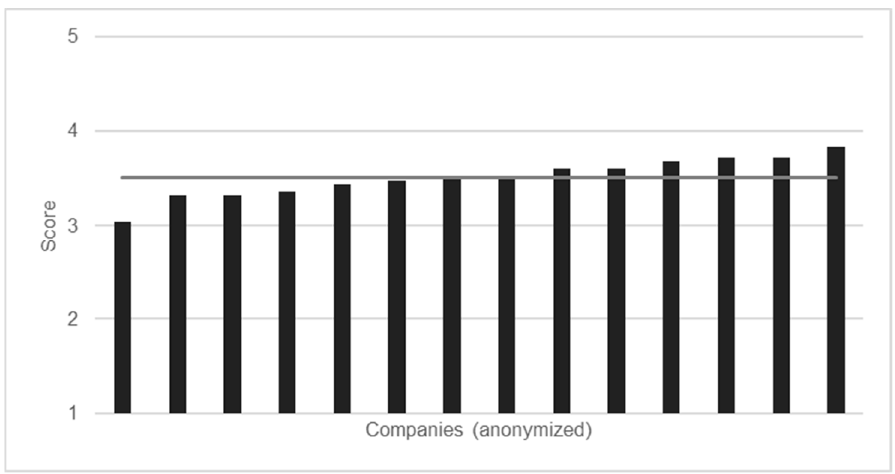
Figure 6. Average score per company (anonymized).